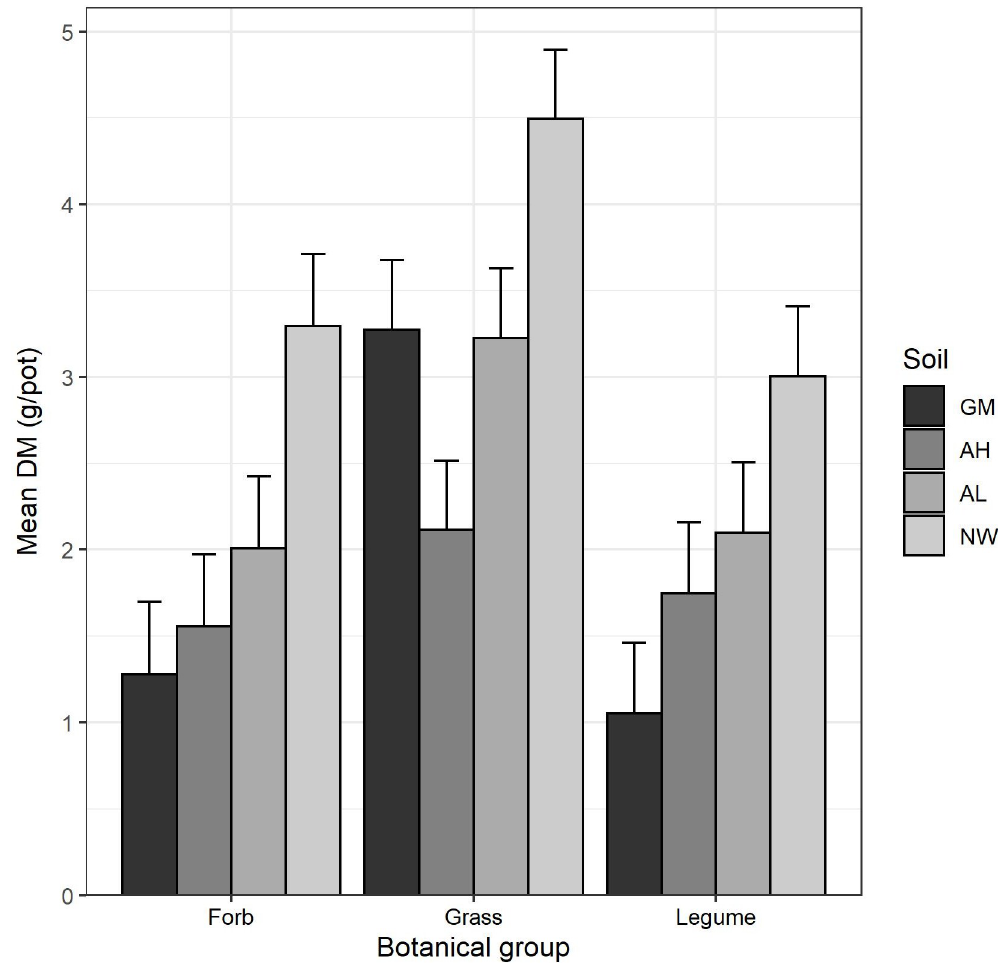
Fig 1. Mean dry matter (DM) yield of botanical groups across the GM, AH, AL and NW soils. Error bars are one standard error. The average least significant difference (LSD) across treatments was 0.497.